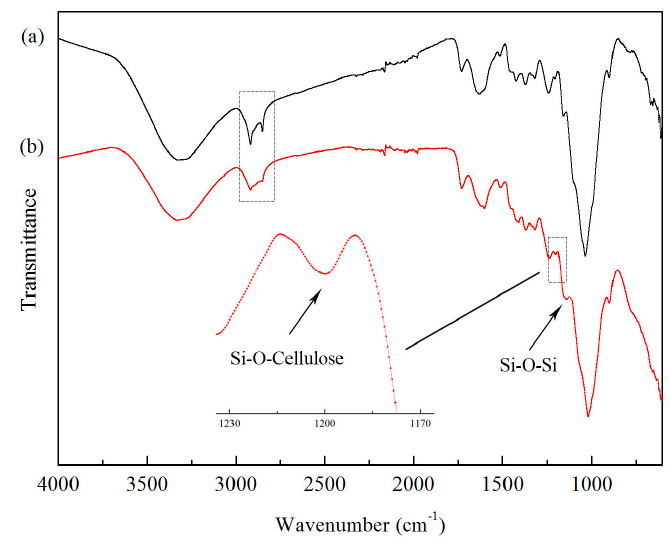
Figure 5. FTIR spectra of ( a ) untreated wheat straw fiber and ( b ) wheat straw fiber treated by A171 and modified TiO 2 nanoparticles.